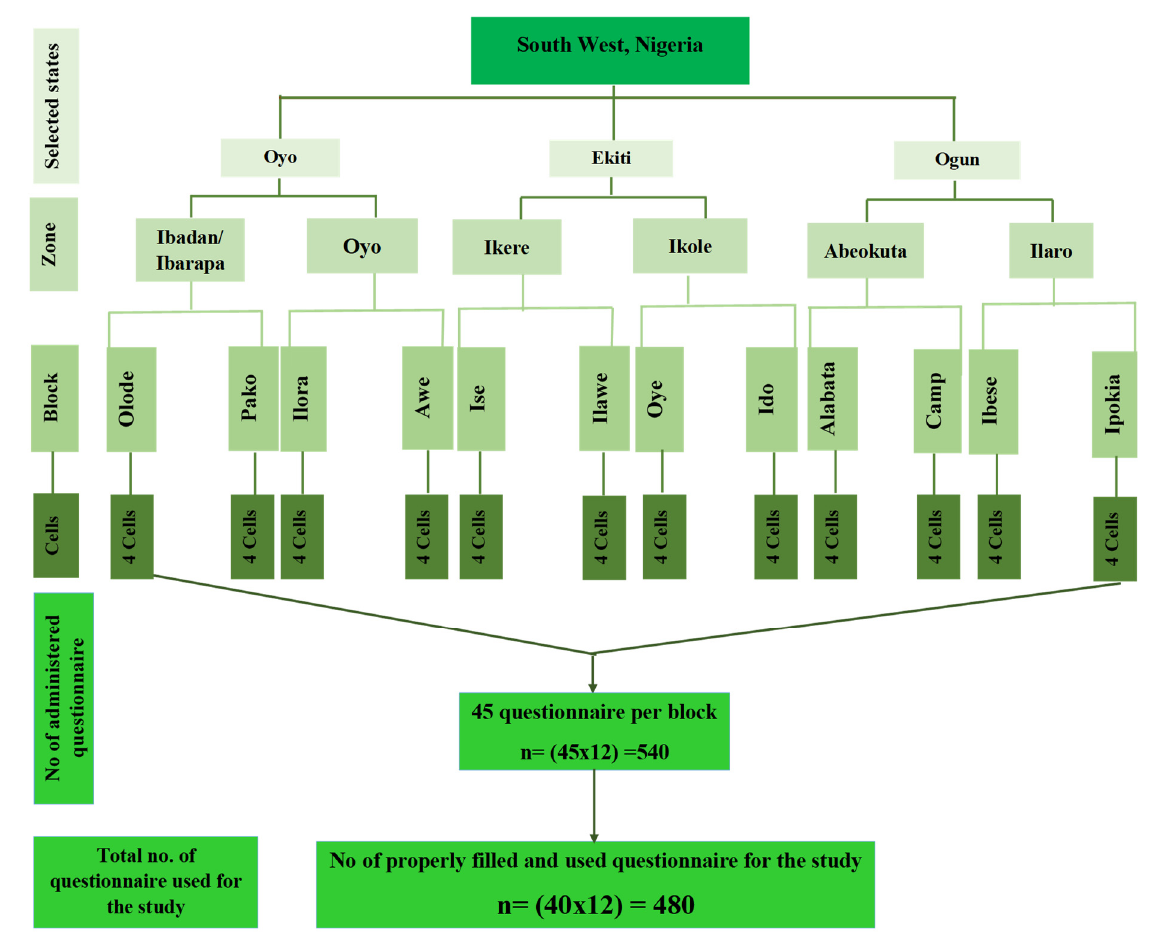
Figure 3. Framework used for sampling method and sample size for the study.